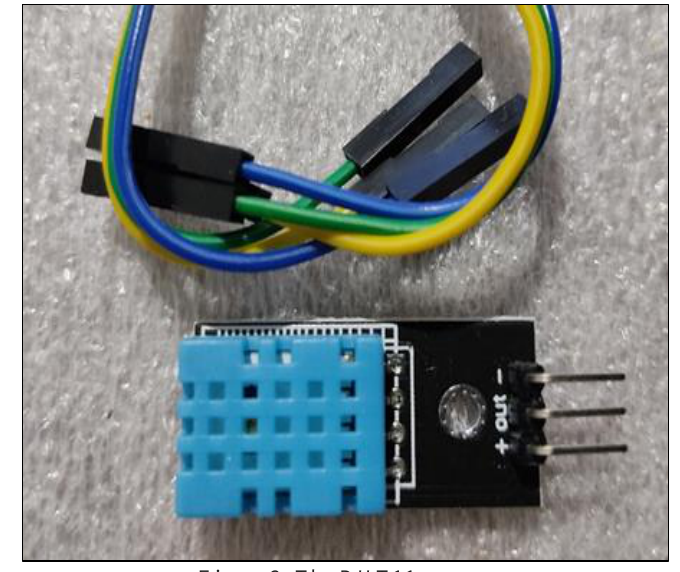
Figure 3: The DHT11